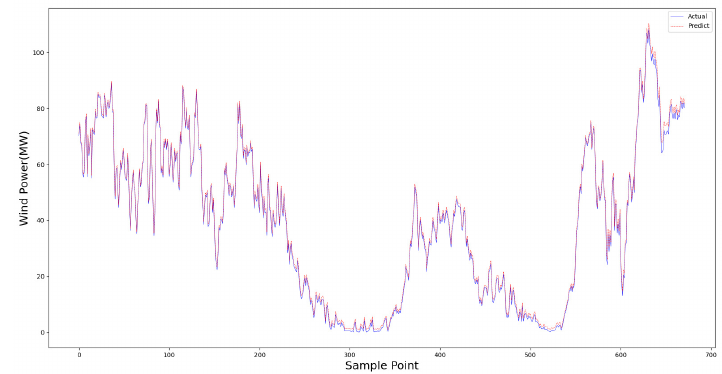
Figure 9. The wind power prediction of the test week.